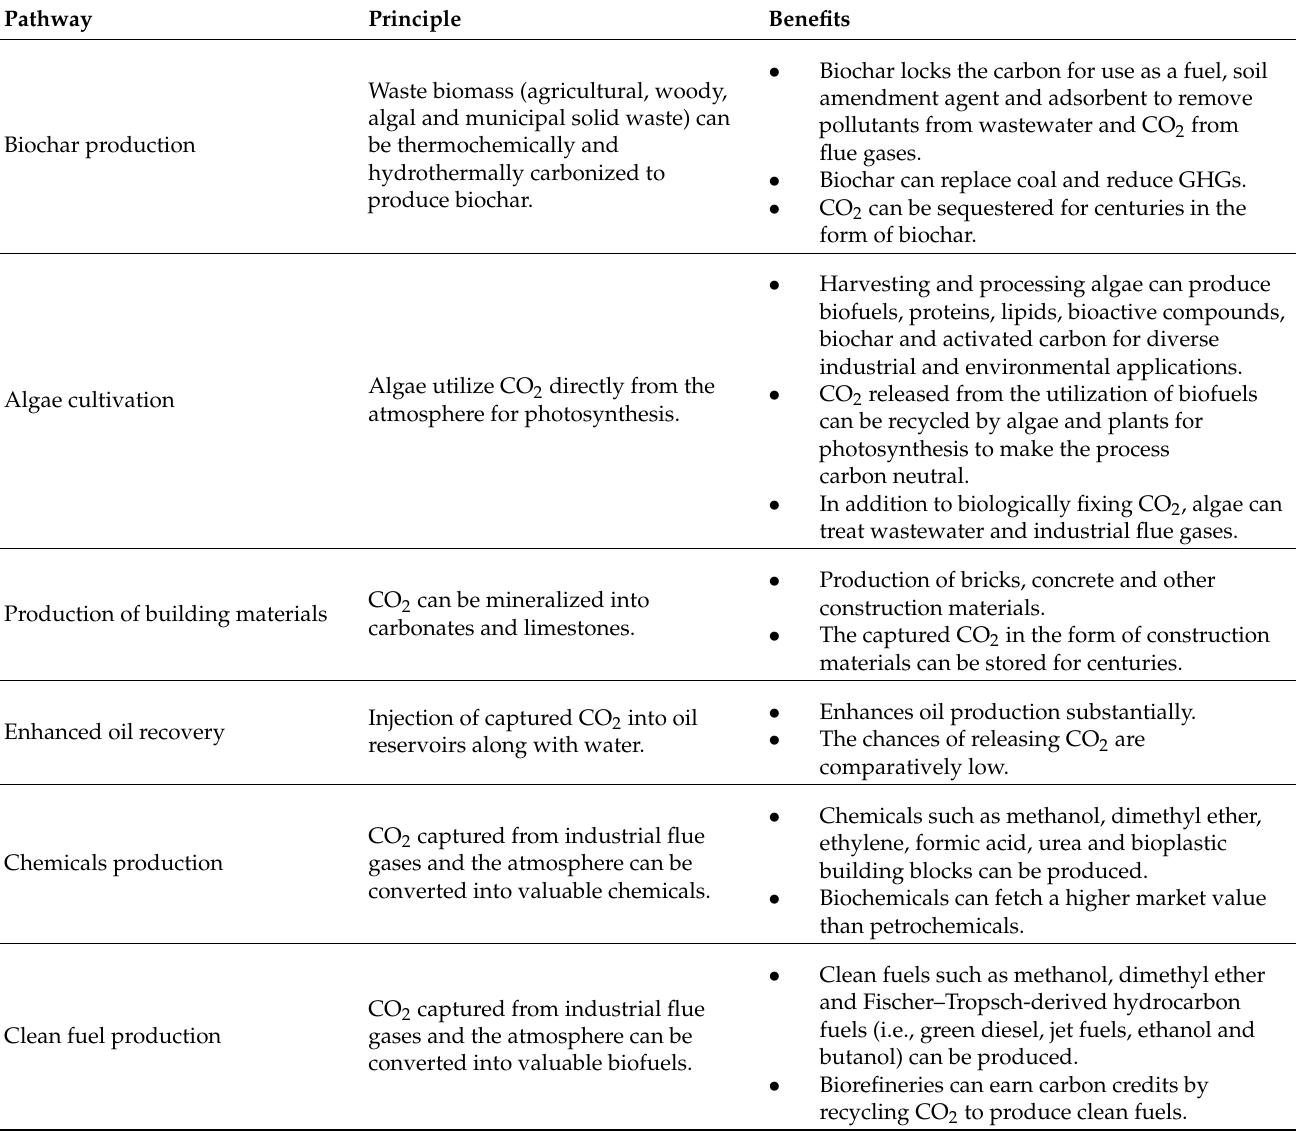
Table 1. Summary of CO 2 utilization